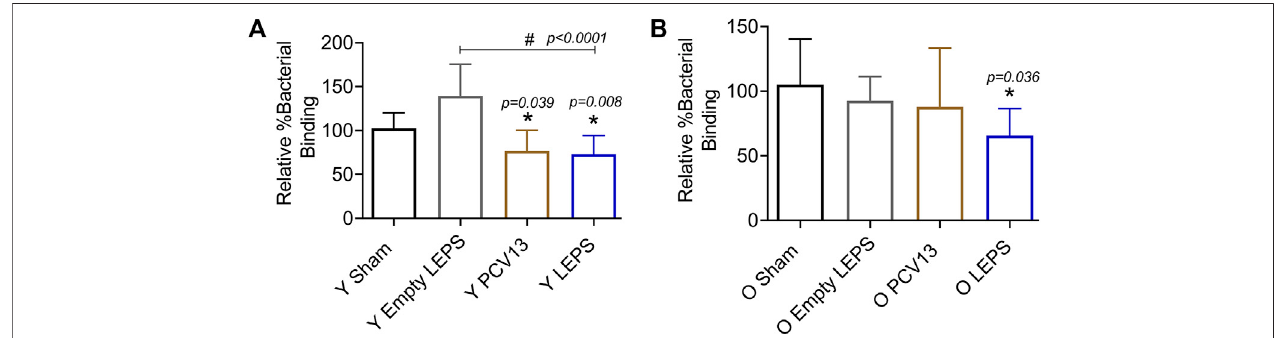
FIGURE 4 | Sera from old mice vaccinated with LEPS, but not Prevnar-13, neutralize the ability of S. pneumoniae to bind pulmonary epithelial cells. Sera were collectedfrommiceimmunizedwithLEPScontainingserotype4capsularpolysaccharideantigen,PCV13,orthecontrols(ShamorEmptyLEPSvector)at4 weekspost vaccination following the timeline indicated in Figure 1B . The ability of sera to neutralize bacterial binding to pulmonary epithelial cells was determined. S. pneumoniae serotype4TIGR4strainwaspre-opsonizedfor45 minwith10%serafromyoung(Y) (A) orold(O) (B) miceandusedtoinfectH292cellsfor1 hatanMOIof10.The numberofboundbacteriawasdeterminedbyplatingonbloodagarplatesandthepercentbacterialbindingcalculatedwithrespecttobacteriaincubatedwithseraalone for each opsonization condition. The effect of sera on bacterial binding was then determined relative to the Sham group. Asterisks (*) indicate signi fi cant differences with respect to the Sham group and hash signs (#) indicate signi fi cant differences between the indicated groups as calculated by one-way ANOVA followed by Tukey ’ s test. Data shown are pooled from four separate experiments where each condition was tested in quadruplicate and presented as mean ± SD.